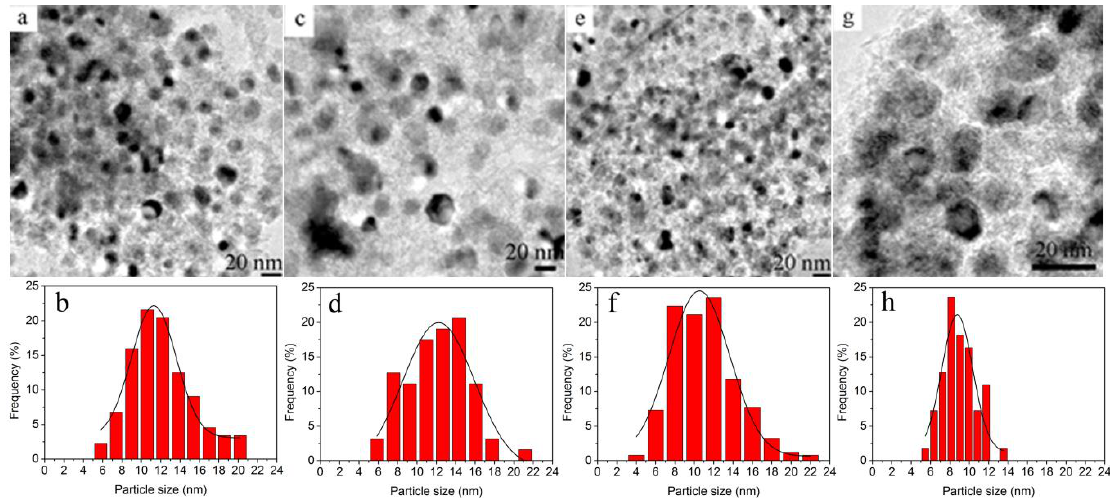
Figure 2. Transmission electron microscopy (TEM) images and size distributions of the supported Ni